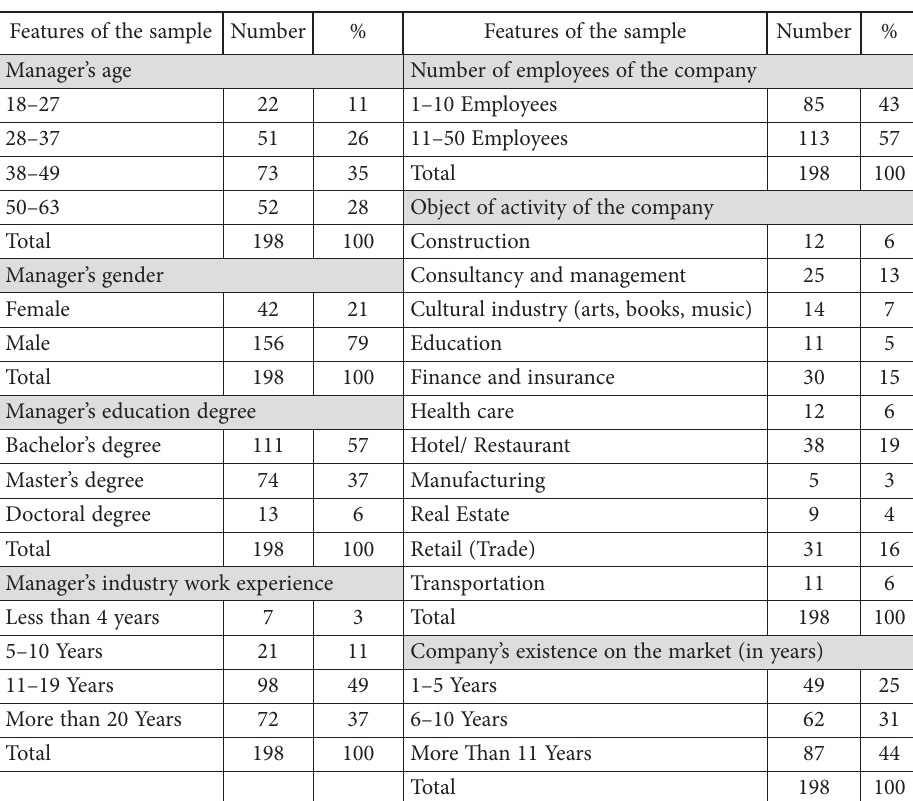
Table 1. Features of the sample (source: own research) Features of the sample Number